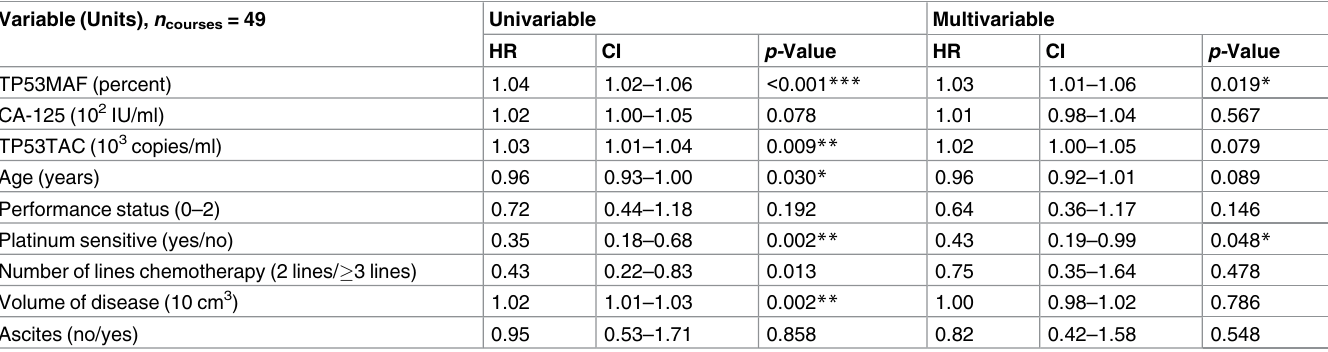
Table 2. Univariable and multivariable analysis of pre-treatment values as a predictor of time to progression. Variable (Units), n courses =